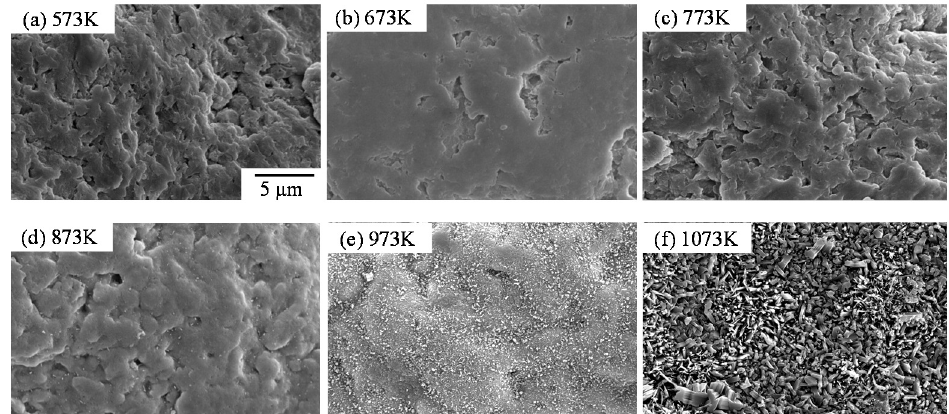
Figure 25. SEM images of surfaces of M10- x K-3h samples.